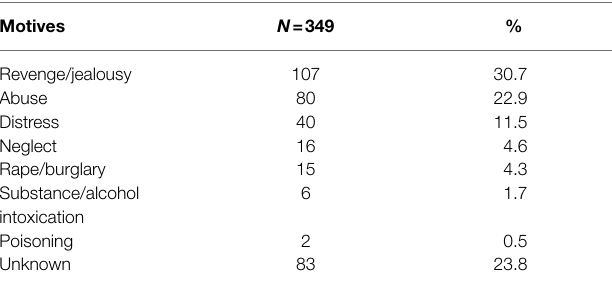
TABLE 3 | Motive of child homicide in Malaysia from January 2010 to June 2021. Motives N = 349